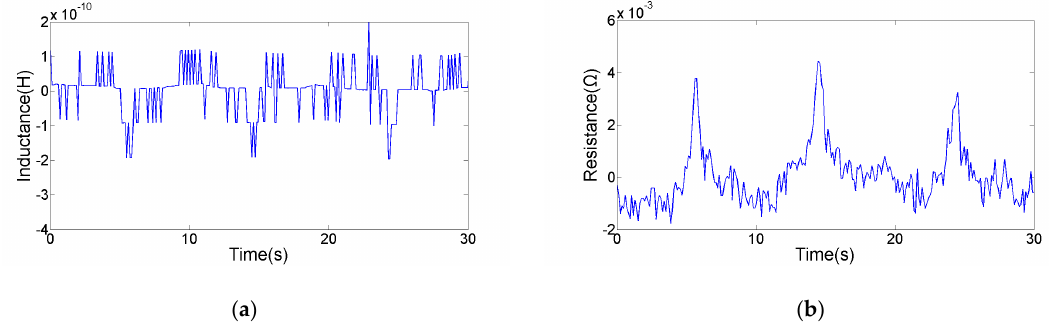
Figure 8. The detection result of 78 μ m copper particle: ( a ) the inductance signal; ( b ) the resistance signal.